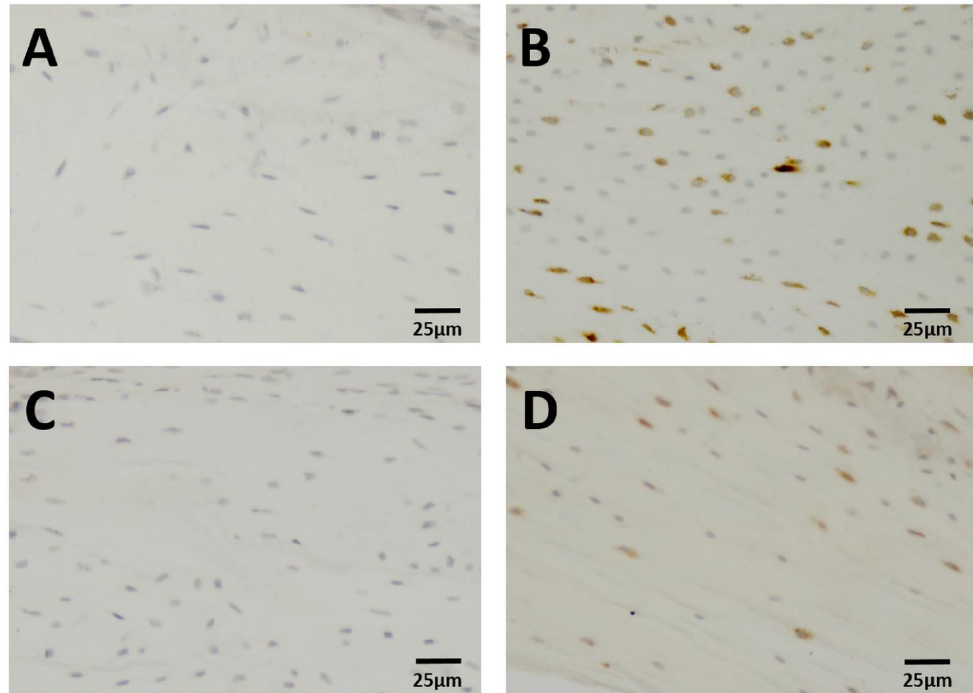
Figure 1. Immunohistochemistry: DKK1 expression in cortical bone of 8-week-old mice ( A ) C57BL/6J: negative control, ( B ) C57BL/6J: osteocytes positive for DKK1 C57BL/6J, ( C ) C3H/J: negative control, ( D ) C3H/J: osteocytes positive for DKK1. Brown-stained osteocytes: positive signal. Osteocytes stained with hematoxylin only: negative signal.